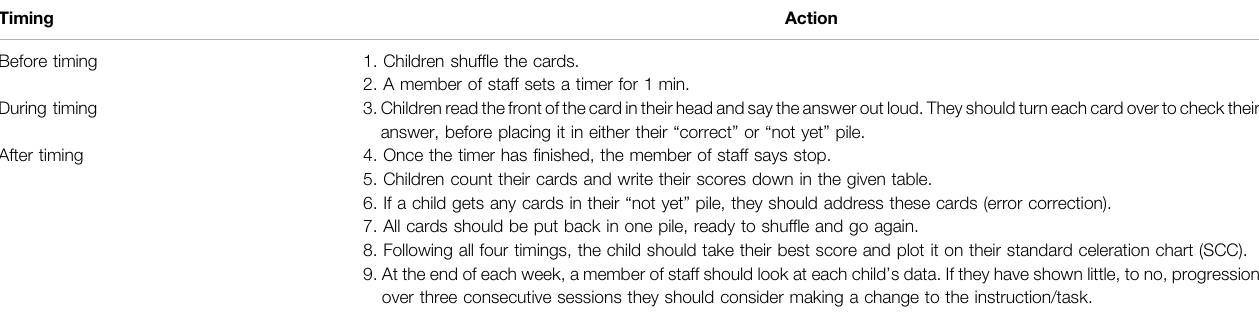
TABLE 1 | An outline of the SAFMEDS strategy.